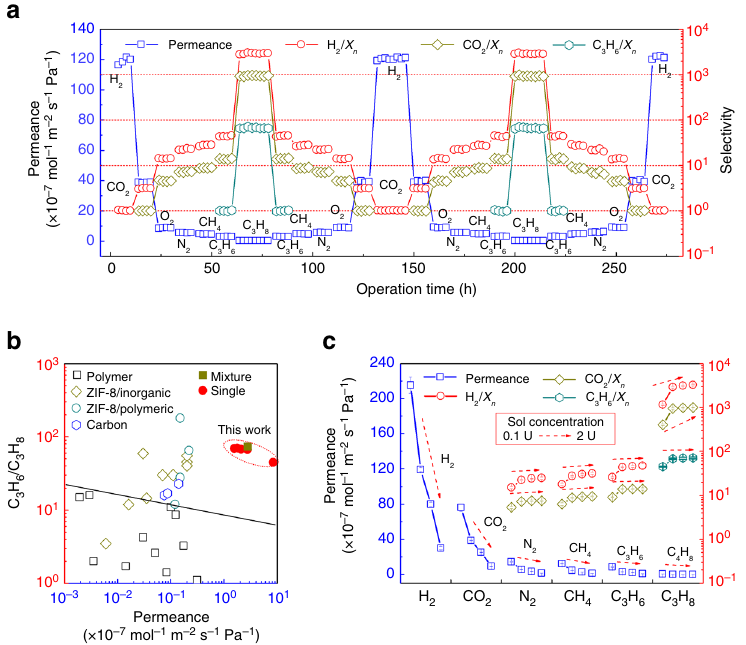
Fig. 3 Gas transport behaviours of ZIF-8 membranes. a Single gas transport behaviours through the ZIF-8 membrane prepared with sol concentration of 1 U, coating time of 2 s and vapour deposition time of 2 h. X n represents various gases. Permeation data were collected for two cycles over 274 h, from smallest H 2 with kinetic diameter of 0.289 nm to largest C 3 H 8 with kinetic diameter of 0.43 nm and then in reverse order. b Comparison of ZIF-8 membranes here with polymeric 50 , carbon 47 and other MOF membranes in literatures for C 3 H 6 /C 3 H 8 system. The black line is the upper bound of polymeric membranes 50 . The numerical data are shown in Supplementary Table 2. The permeance is calculated from the permeability by assuming membrane thickness of 1 μ m. c Single gas permeation behaviours of different gas through ZIF-8 membranes prepared with various sol concentrations of 0.1, 1, 1.5 and 2 U. These ZIF-8 membranes were prepared with coating time of 2 s and vapour deposition time of 2